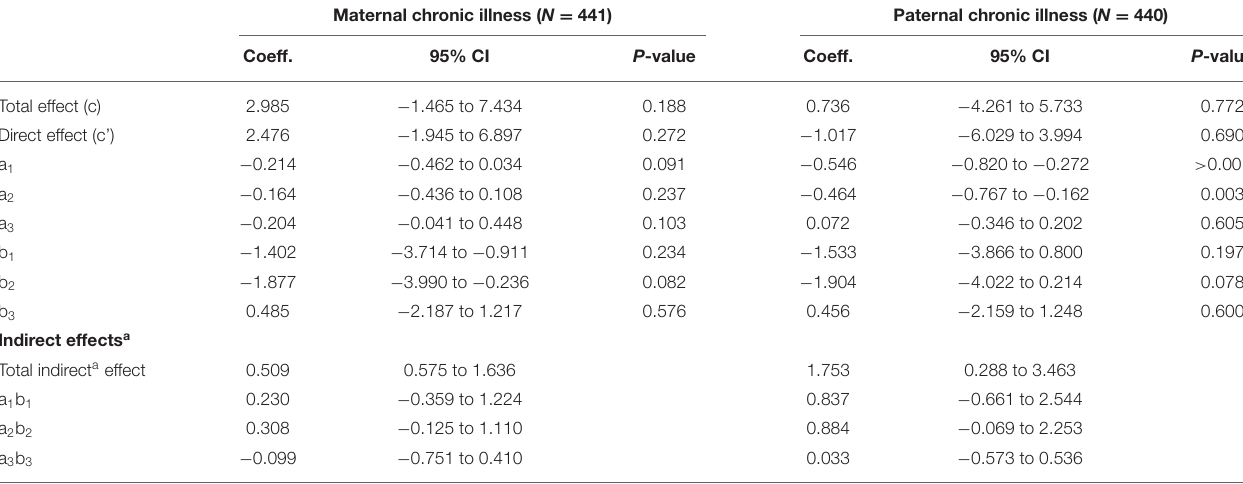
TABLE 5 | Separate analyses for male adolescents: Path coefficients for the parallel mediation models, separate models for maternal and paternal chronic illness. Maternal chronic illness ( N = 441) Paternal chronic illness ( N = 440) Coeff. 95% CI P -value Coeff. 95% CI P